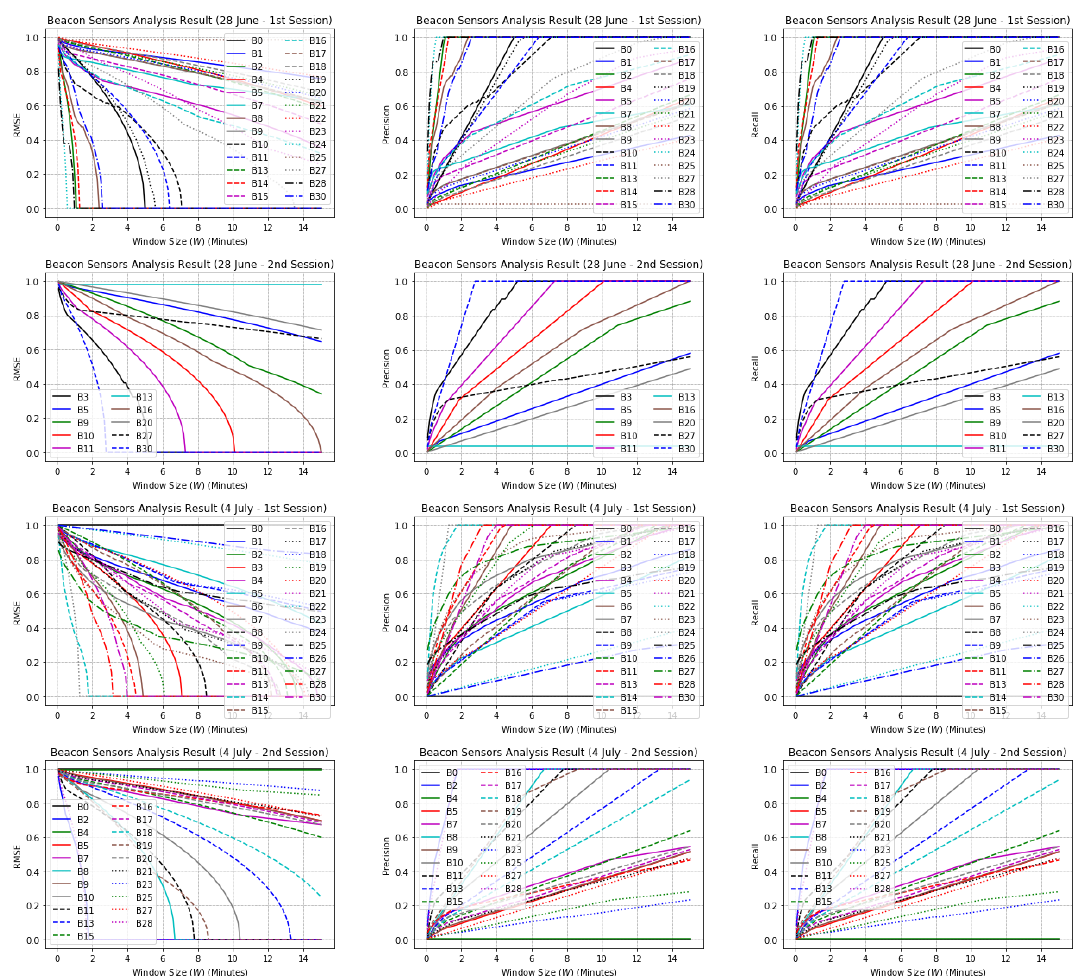
Figure A2. TSR analysis: (left column) RMSE value, (middle column) precision score, and (right column) recall score of beacon sensors (shown in different colors) for different window sizes in each